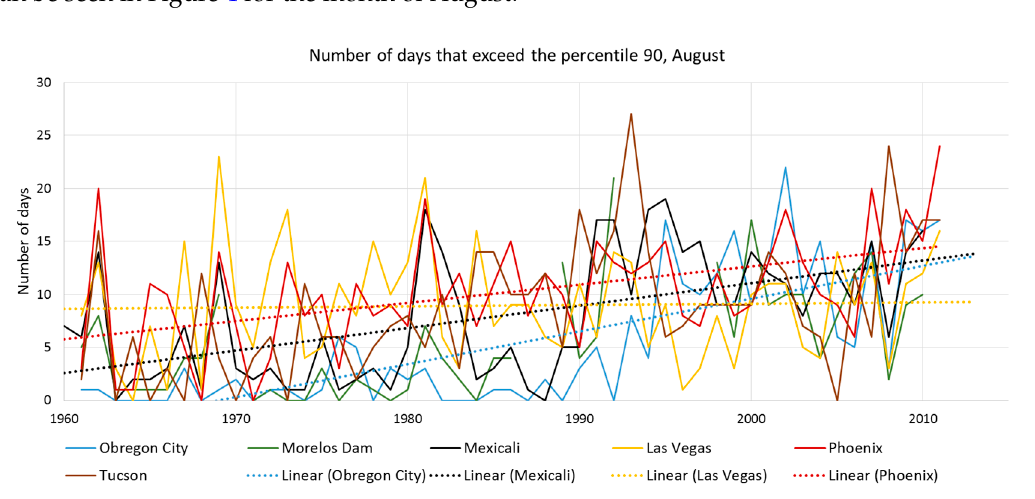
Figure 4. Number of days that exceeded the 90th percentile of average maximum temperatures threshold in August. threshold in